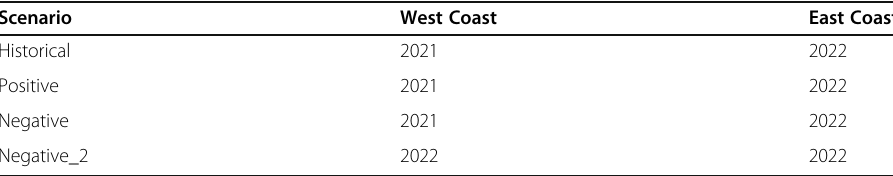
Table 8 Results of